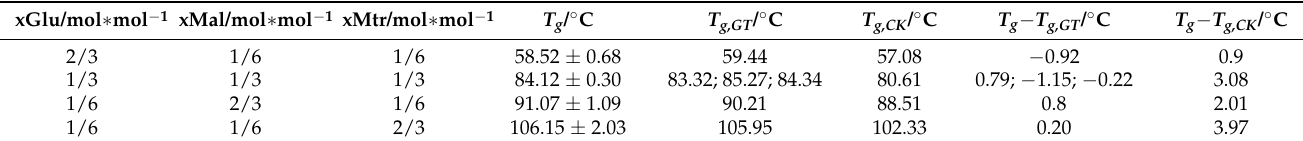
Table A1. Molar fractions ( x ), measured glass transition temperatures ( T g ), and glass transition temperatures according to the Gordon–Taylor ( T gGT ) and Couchman–Karasz equations ( T gCK ) of the ternary glucose mixtures. For the equimolar mixtures, the three glass transition values of the Gordon– Taylor equation correspond to fit of binary mixtures with varying glucose, maltose, maltotriose, and equimolar rest in this order.